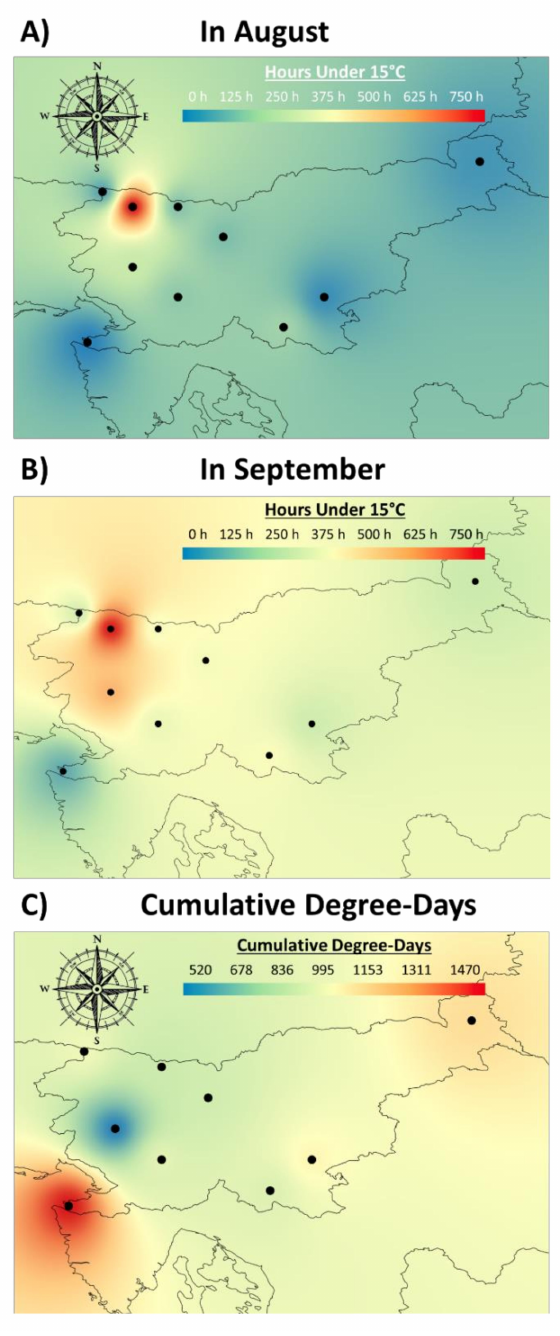
Figure 1. Spatially interpolated values among weather stations (denoted by black dots) for hours that the ambient temperature is below the threshold of 15 ◦ C in Slovenia for: ( A ) August; ( B ) September; and ( C ) cumulative degree-days calculated using the Baskerville-Emin method, starting August 1 based on 10-year historical average values, and a lower developmental threshold of 15 ◦ C. Most of Slovenia has at least 120 h of ambient air temperature under 15 ◦ C, suggesting that grain aeration may be a useful additional pest management tactic for the